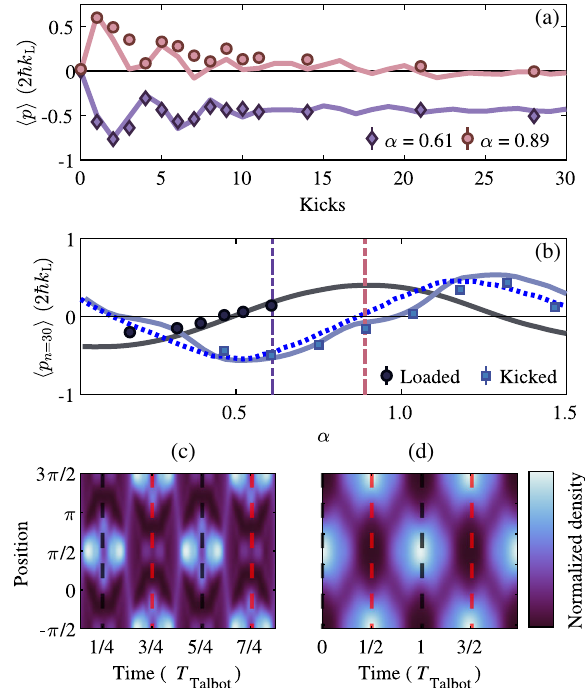
FIG. 3. Initial-state dependence of the quantum boomerang effect. All error bars show standard error of the mean on repeated measurements. (a) Average momentum versus kick number for an initial state consisting of a BEC kicked once by a 60 E lattice. R Pink circles correspond to α ¼ 0 . 89 and purple diamonds to α ¼ 0 . 61 for T ¼ 7 μ s. Solid lines are predictions of TDSE numerics. (b) Average momentum after 30 kicks versus α , for an initial condition set by adiabatic loading of a BEC into a 7 E lattice (gray R circles) and an initial condition set by kicking a BEC once with a 60 E lattice (blue squares). The dotted blue line shows infinite- R time average momenta predicted by the Floquet diagonal ensemble [Eq. (A5)]. Dashed vertical lines correspond to α values in panel (a). (c,d) Calculated density evolution over two Talbot times of a BEC kicked by a 60 E lattice (left) and a a BEC adiabatically R loaded into a 7 E lattice, which is then quenched off (right). R Dashed vertical lines represent time-reversal symmetry